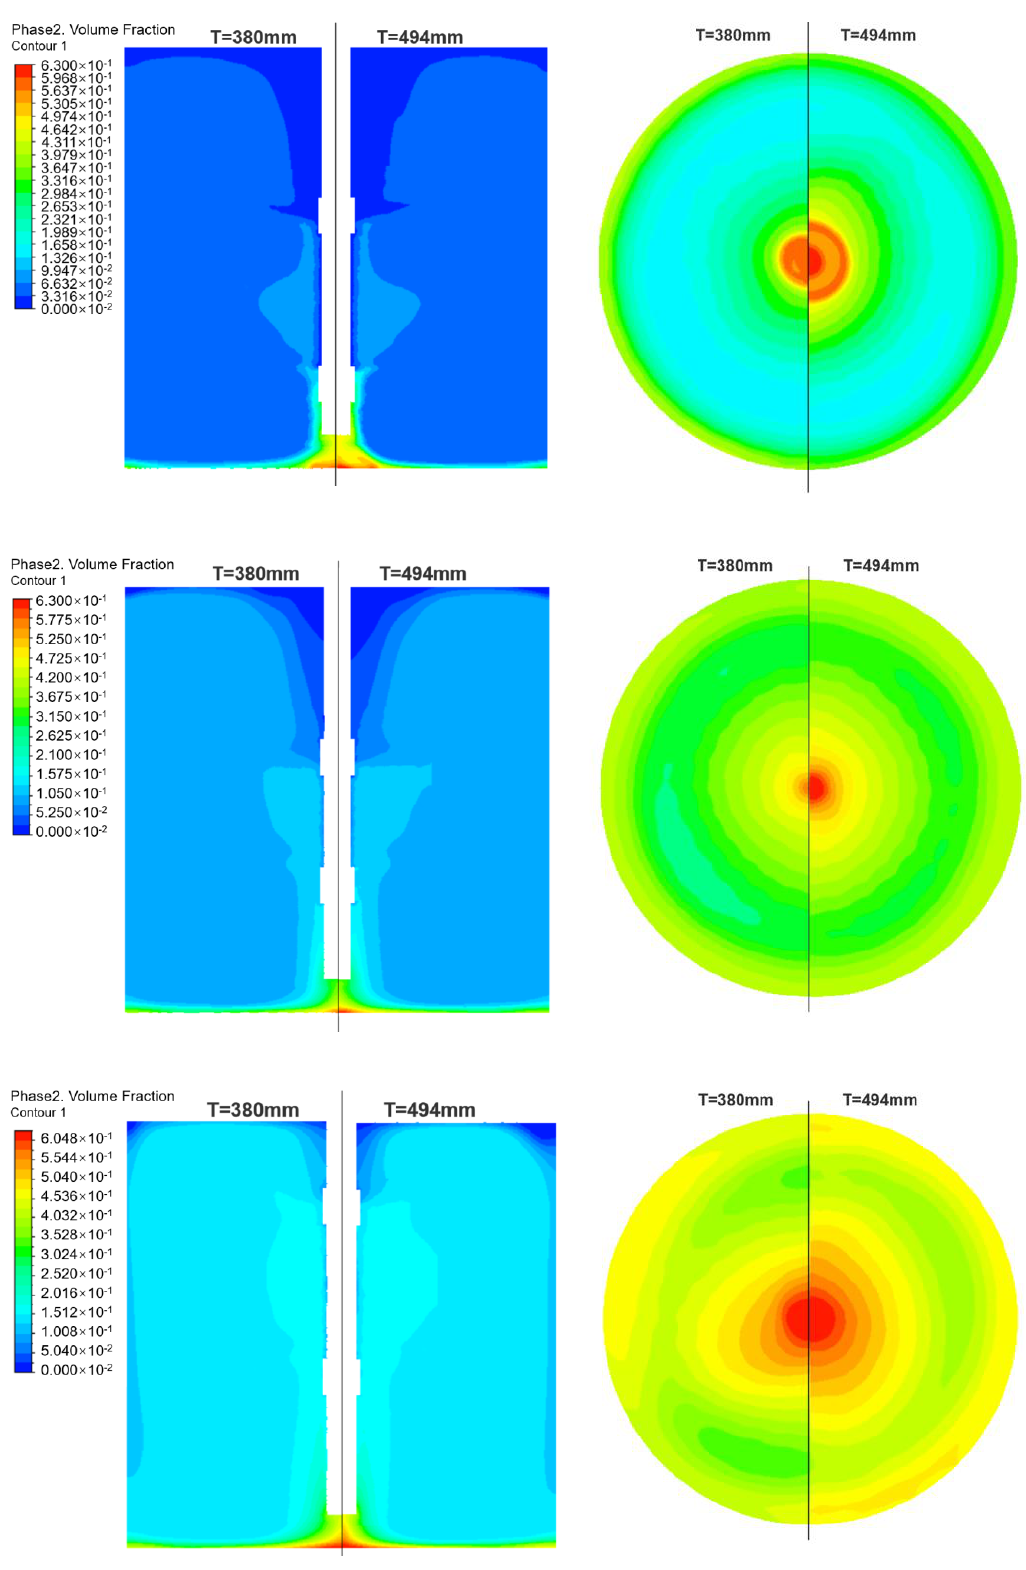
Figure 9. Comparison of solid concentration distributions scaled up based on the same Weber number: ( a ) Co = 5% v/v ; ( b ) Co = 10% v/v ; ( c ) Co = 15% v/v . Table 8 records the solid uniformity σ of the tanks before and after scaling up, ac- cording to the same Weber number criterion under different solid content. As can be seen from Table 8, with the increase in solid content, the gap of solid uniformity in the tanks became larger before and after scaling up. Therefore, this scale-up criterion is only appli- cable to anaerobic fermentation mixing systems with a solid content of less than 5%.